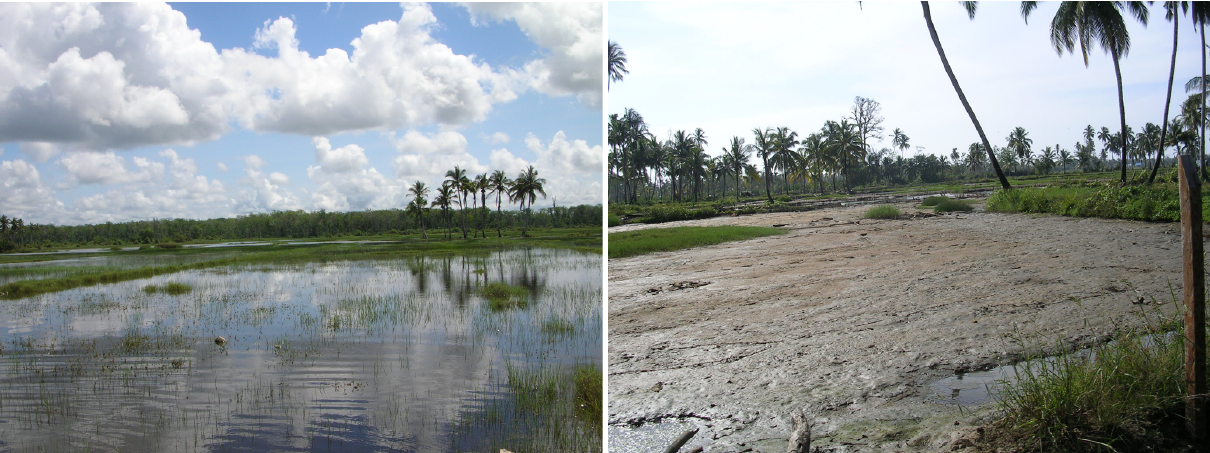
Fig. 1. (left) Subsided land 200m from the sea in Suak Nie, near Meulaboh, Aceh Barat, Indonesia, as consequence of the earthquake, and (right) tsunami mud deposits, 100m from the